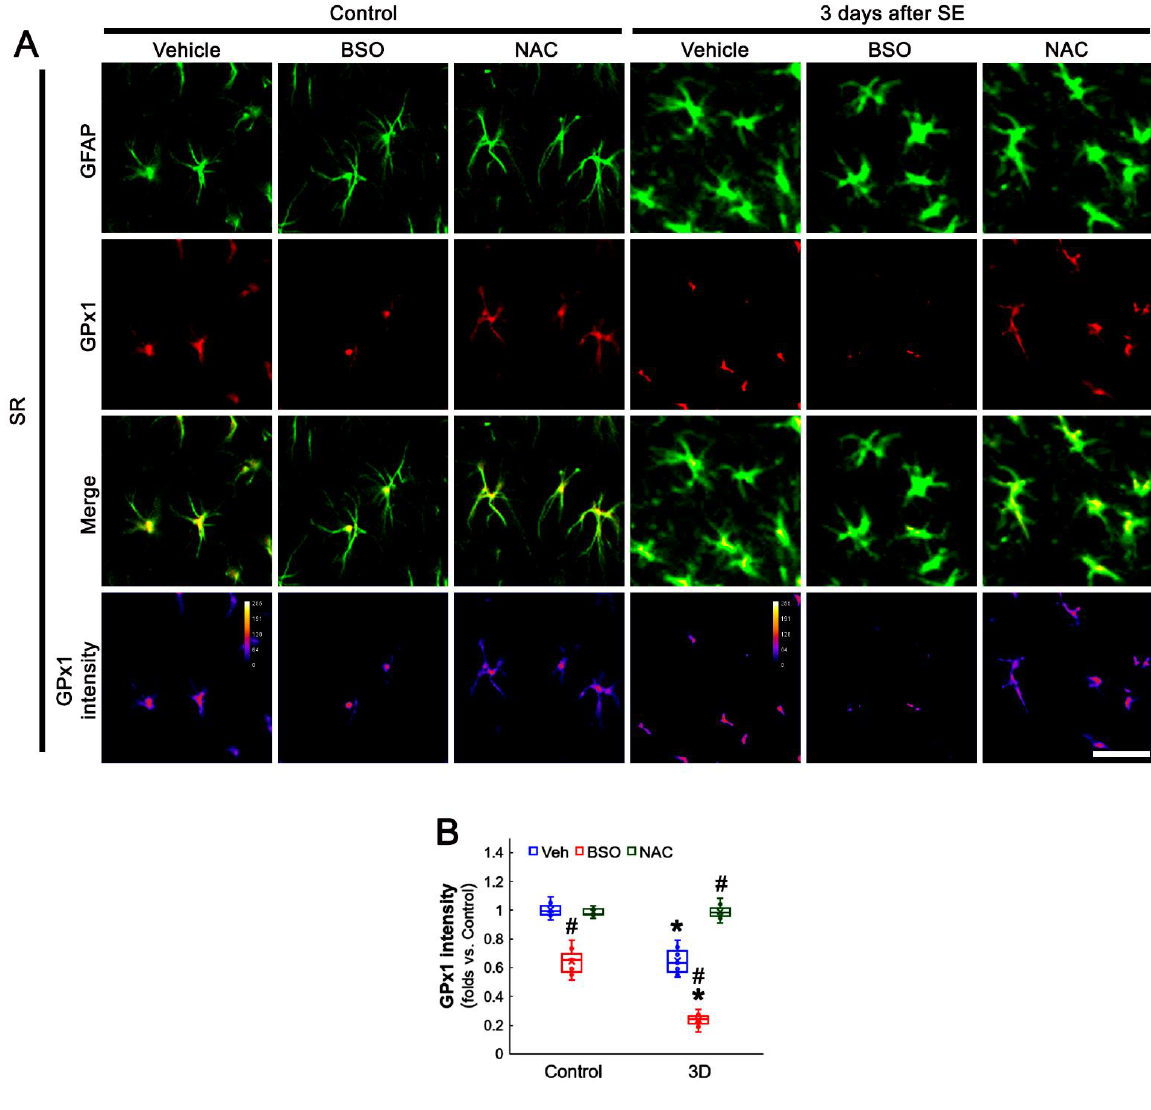
Figure 6. Effects of BSO and NAC on GPx1 expression in the stratum radiatum (SR) of the CA1 region under physiological- and 1 day-post-SE condition. Under physiological conditions, BSO reduces GPx1 expression, while NAC does not affect it, as compared to vehicle (Veh). Three days after SE, BSO more decreases GPx1 expression. NAC restores GPx1 expression to the control level. ( A ) Representative photos of GPx1 expression and its intensity. Bar = 25 μm. (B -C) Quantification of GPx1 ( B ) intensity in CA1 astrocytes ( C ) (*, # p < 0.05 vs. control and vehicle, n = 7, respectively).